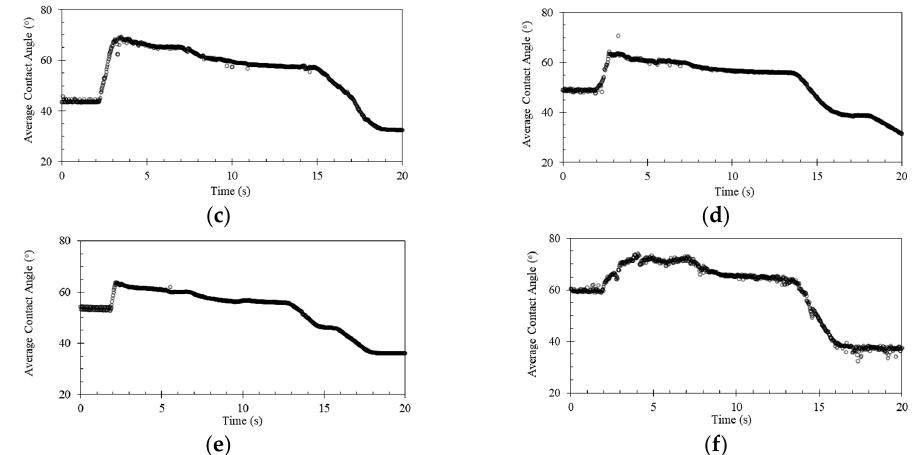
Figure 7. Changes of the water contact angles of the Ti6Al4V surface coated with ( a ) pDA, ( b ) pDA-KR12, ( c ) pDA-KR12/32, ( d ) pDA-KR12-5911, ( e ) pDA-KR12/32-5911, and ( f ) Ti6Al4V without coating, showing the changes in the water droplet's volume.